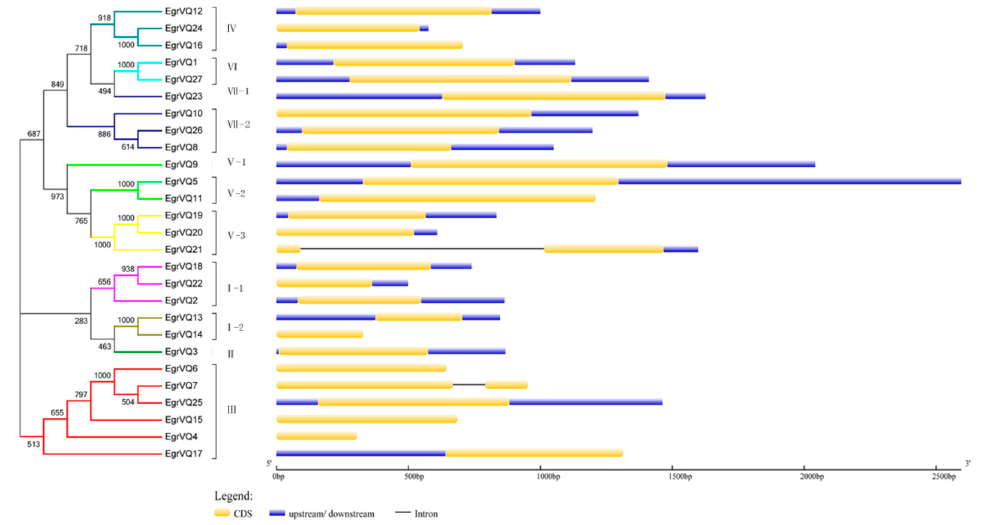
Figure 4. Gene structure of VQ genes in E. grandis . Exons were indicated by yellow rectangles. Upstream/downstream’s sequences of EgrVQs were indicated by blue lines. Gray lines connecting two exons represented introns.